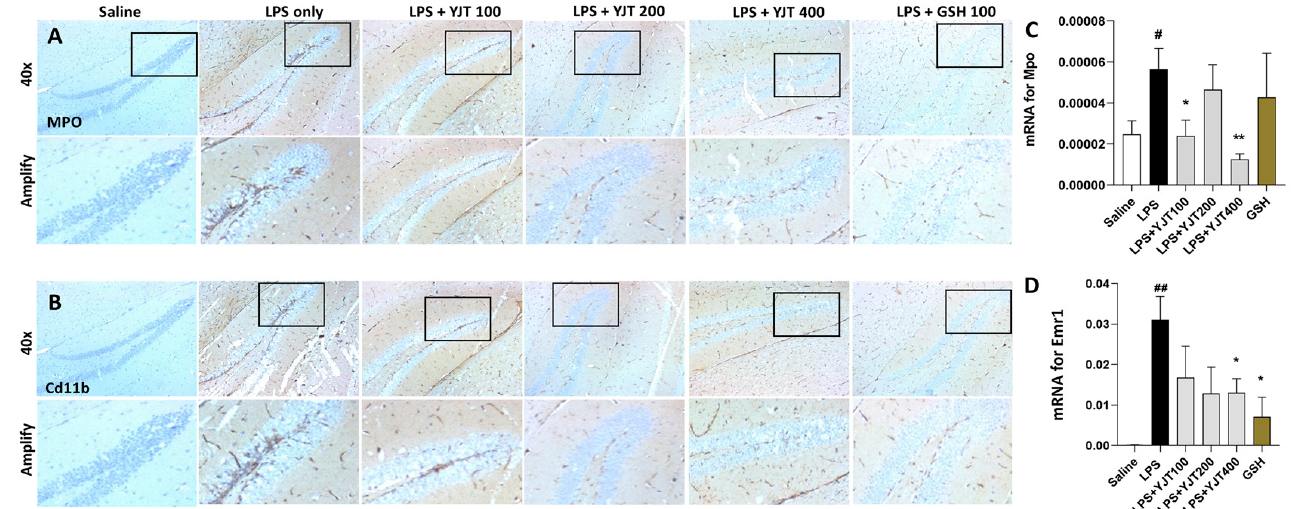
Figure 3. Immunohistochemistry analysis and qPCR analysis for neuroinflammatory factors. After the last injection of LPS, mice were sacrificed and brain tissues were removed and stored in the neutral formalin solutions for further analysis. Immunohistochemistry analysis was performed specifically against ( A ) MPO and ( B ) Cd11b ( n = 3–4 to each group), and qPCR analysis for Mpo ( C ) and Emr1 ( D ) ( n = 4–6 to each group). The data were expressed as mean ± SEM. # p < 0.05, and ## p < 0.01 for Con vs. LPS, * p < 0.05, and ** p < 0.01 for LPS vs. drug–administrated groups. The scale bars on the 40 × indicate 250 µm and amply pictures for 100 µm, respectively.